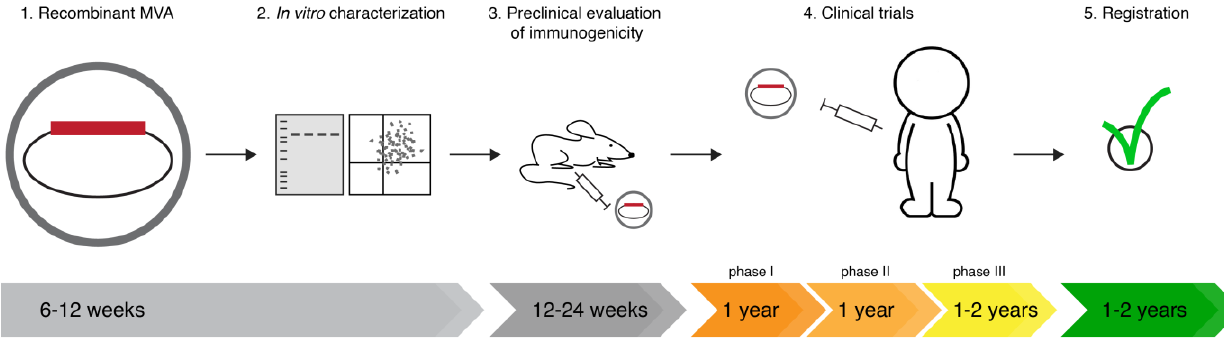
Figure 2. Ideal timeline for evaluation of a novel MVA-based vaccine. ( 1 ) A